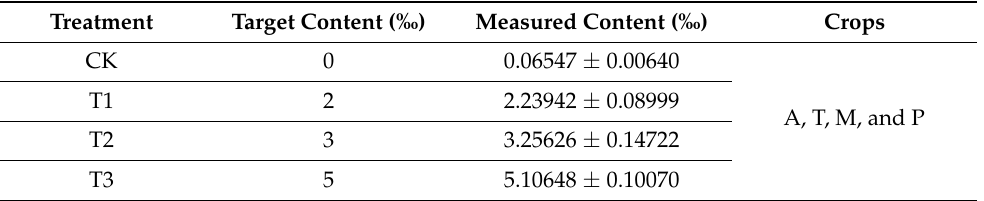
Table 2. Test design and measured Pb content in polluted soil (mean ±